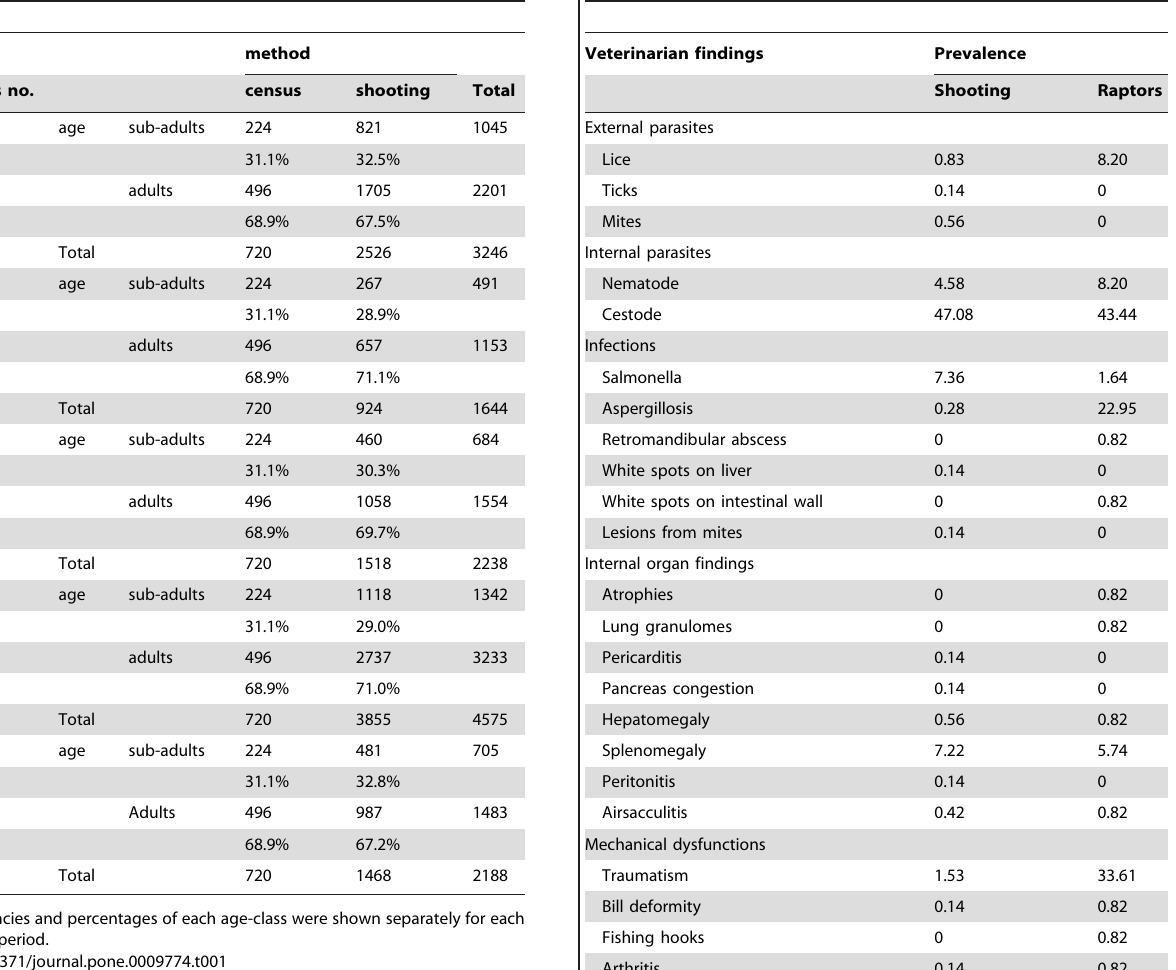
Table 1. Frequencies of gulls of each age-class (sub-adults and adults) counted during the censuses and compared with those of gulls shot at the dump.